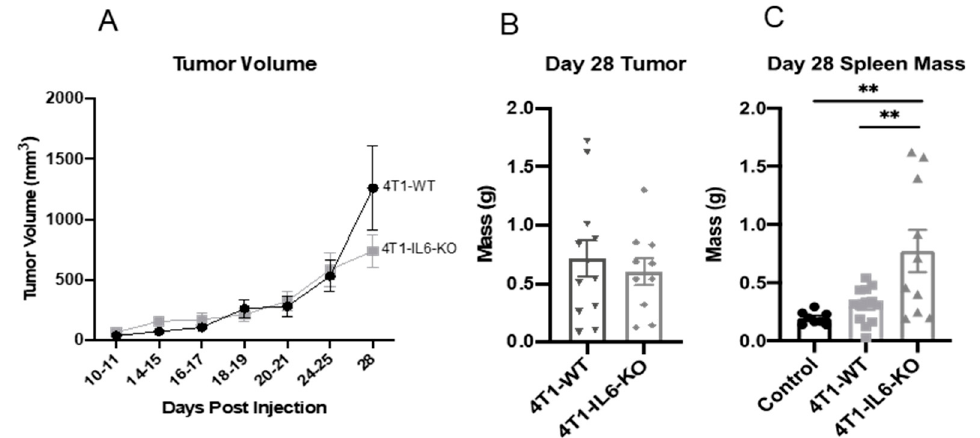
Figure 8. Tumor characteristics and spleen mass in 4T1–WT vs. 4T1–IL6–KO mice. ( A ) The 4T1-WT and 4T1-IL6-KO tumor volumes were measured over time; no statistically significant differences ( p > 0.05) were detected. ( B ) Final 4T1-WT and 4T1-IL6-KO tumor mass at d 28 post engraftment. ( C ) Spleen mass at d 28 following tumor engraftment; healthy non-tumor-bearing spleens included for reference. The 4T1-IL6-KO spleens were significantly heavier than 4T1-WT and non-tumor-bearing controls. Note that 4T1-IL6-KO is a 4T1-cell-specific IL-6 knockout, not whole animal. ANOVA with Tukey’s multiple comparisons. Data are presented as mean ± SEM and n = 6–11 mice/group. ** p < 0.01.